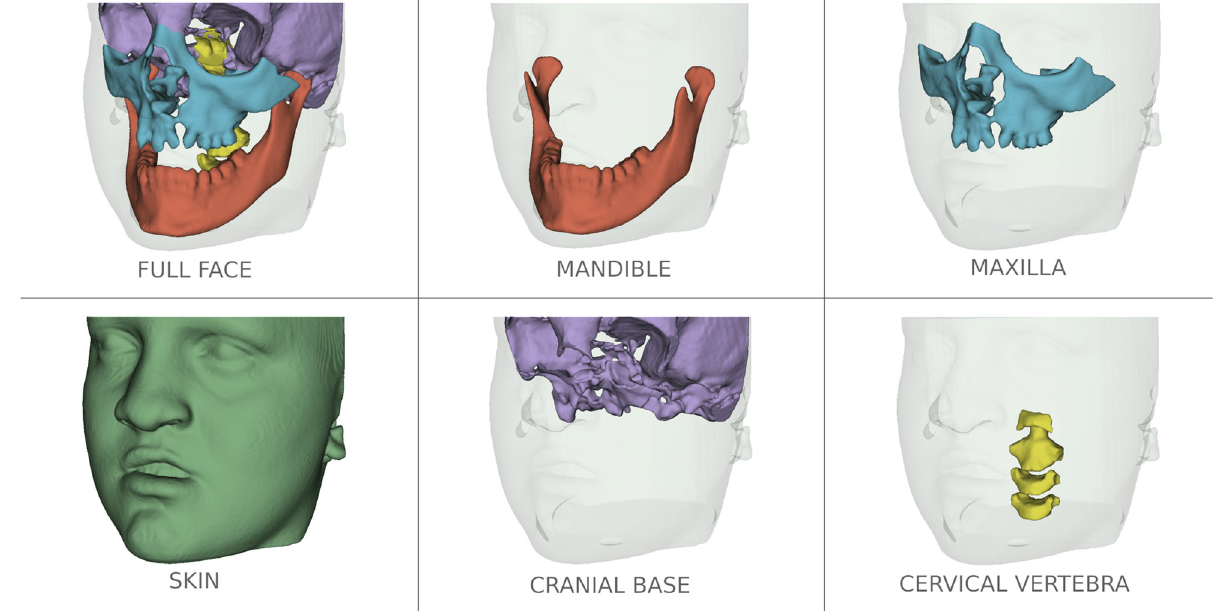
Fig 1. Multi-anatomical skull structure manual segmentation of the full-face by combining the mandible, the maxilla, the cranial base, the cervical vertebra, and the skin segmentation. Patient has written consent on file for the use of the images.